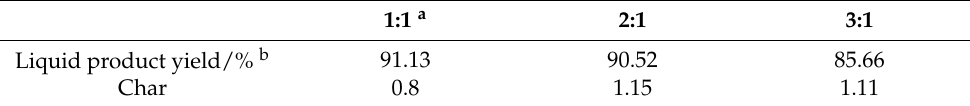
Table 2. The liquid product yield after esterification pretreatment with different methanol/bio-oil mass